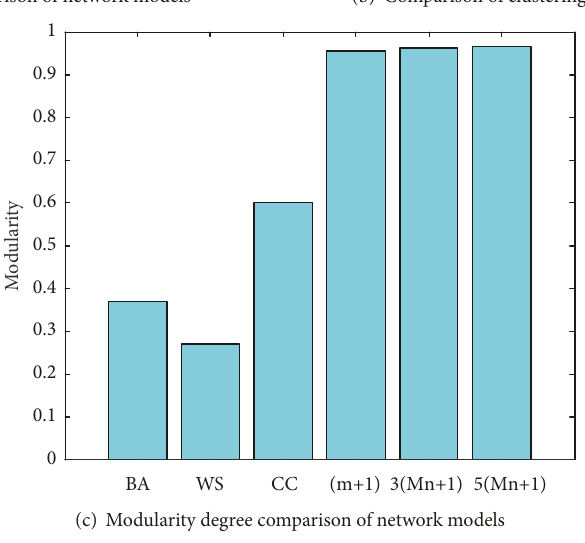
(a) Average degree comparison of network models (b) Comparison of clustering coefficients of network